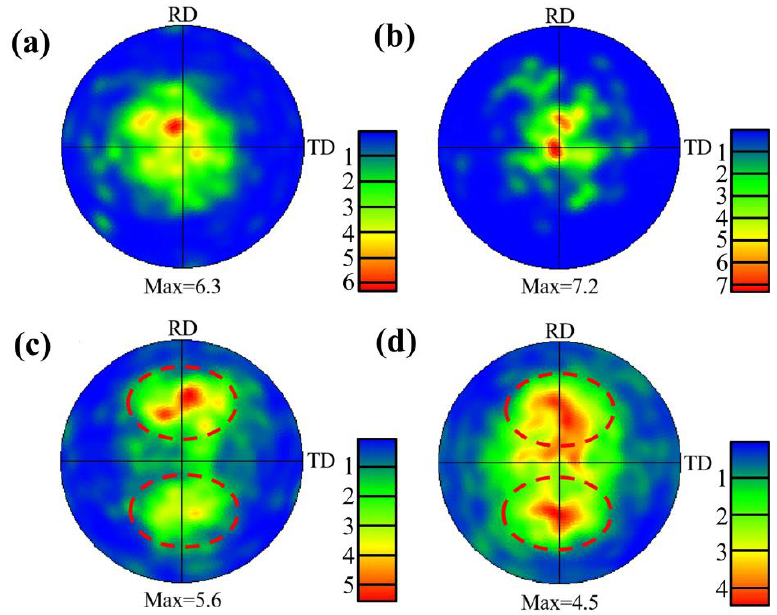
Figure 7. (0002) Pole figures of the different samples after annealing: ( a ) upper surface of HTRA sample; ( b ) mid-layer of HTRA sample; ( c ) upper surface of HTR-CBA sample; ( d ) mid-layer of HTR-CBA sample.